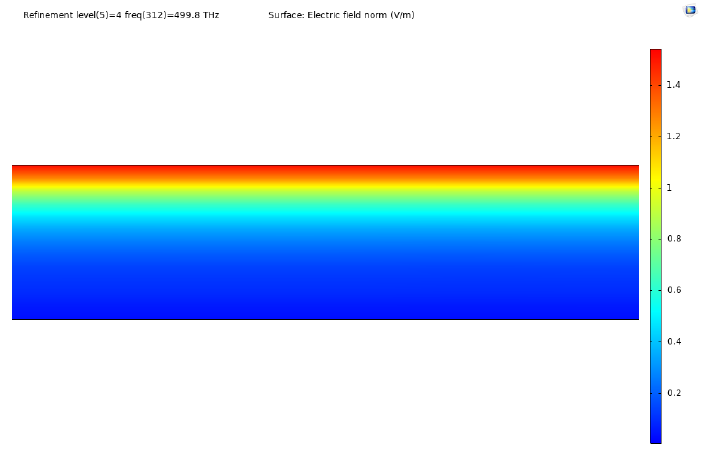
Figure A1. Electric field norm of Al 0.18 Ga 0.33 In 0.49 P at 200 THz and 500 THz.